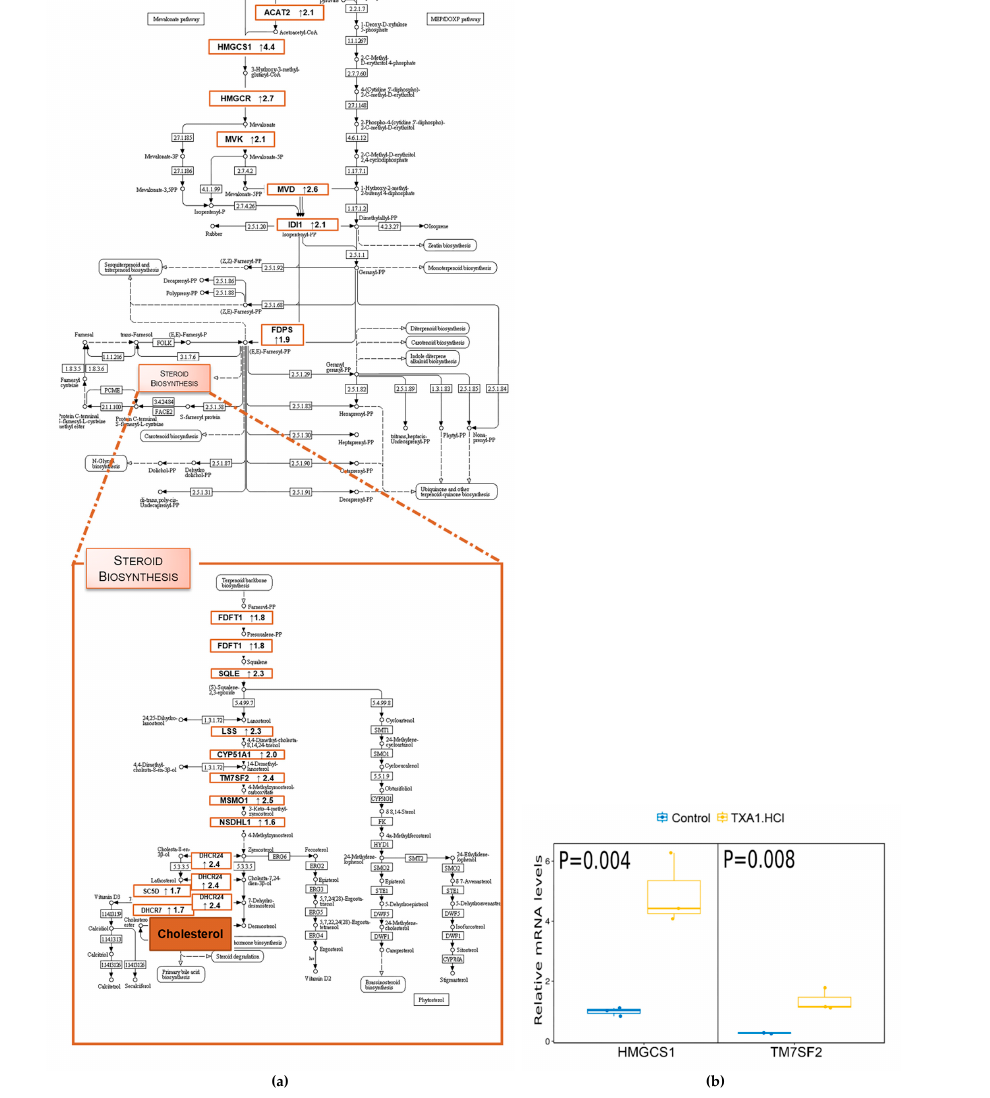
Figure 5. ( a ) KEGG pathways with significantly differential gene expression from this study were highlighted, including the direction of regulation (up or downregulation). Each colored box has the gene name abbreviated and a number representing the ≥ 1.5-fold relative to the control. KEGG pathway background images were adapted from www.genome.jp/kegg/ [21–23]. ( b ) HMGCS1 and TM7SF2 mRNA levels, analyzed by quantitative real-time PCR. Values are expressed after normalization for an endogenous control. Data plotted with ggplot and p value were calculated using t. test in R statistical programming language comparing TXA1.HCl vs control. Gene names: ACAT2, acetyl-coenzyme A acetyltransferase 2; HMGCS1, 3-hydroxy-3-methylglutaryl-coenzyme A synthase 1; HMGCR, 3-hydroxy-3-methylglutaryl-coenzyme A reductase; MVK, mevalonate kinase; MVD, mevalonate (diphospho) decarboxylase; IDI1, isopentenyl-diphosphate δ -isomerase 1; FDPS, farnesyl